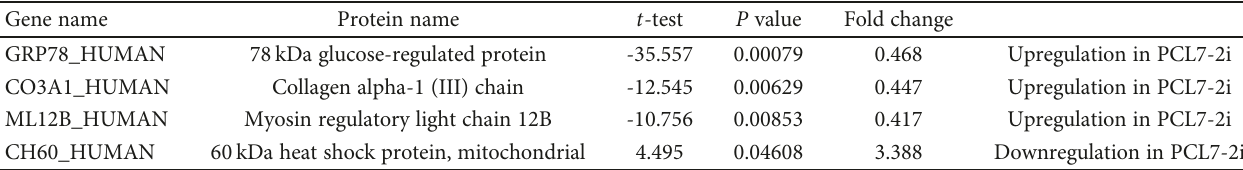
Figure 6: Collagen type I and type III production ((a); ∗ and ∗∗ p < 0 0001 ) and in collagen type I/type III ratio ((b); ∗ p < 0 0001 ) in PCL7-2i and control samples. Table 5: Di ff erentially expressed proteins in ECM protein